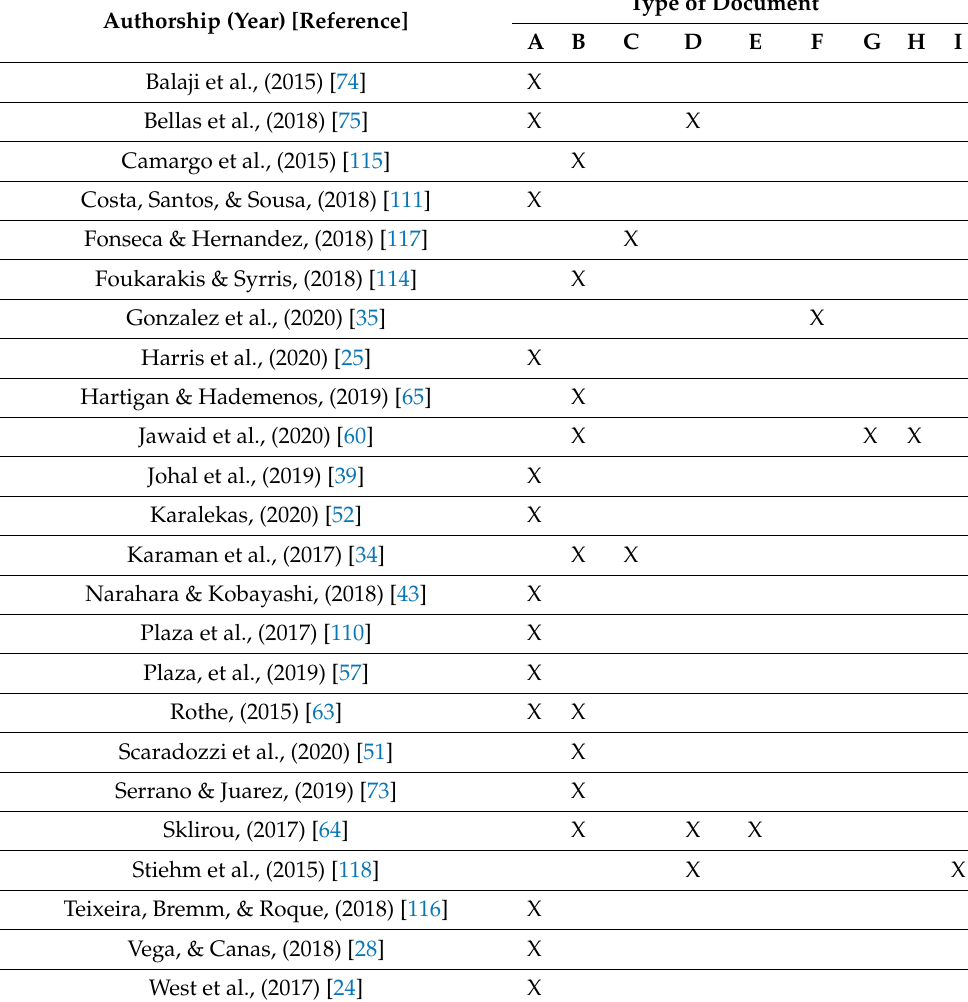
Table 4. Classification of the papers selected by type of teaching-learning strategy implemented: (A) Learning by doing, (B) Project-based learning, (C) Challenge-based learning, (D) Problem solving, (E) Discovery learning, (F) Competency-based learning, (G) Collaborative learning, (H) Adventure- based learning, and (I) Simulation-based